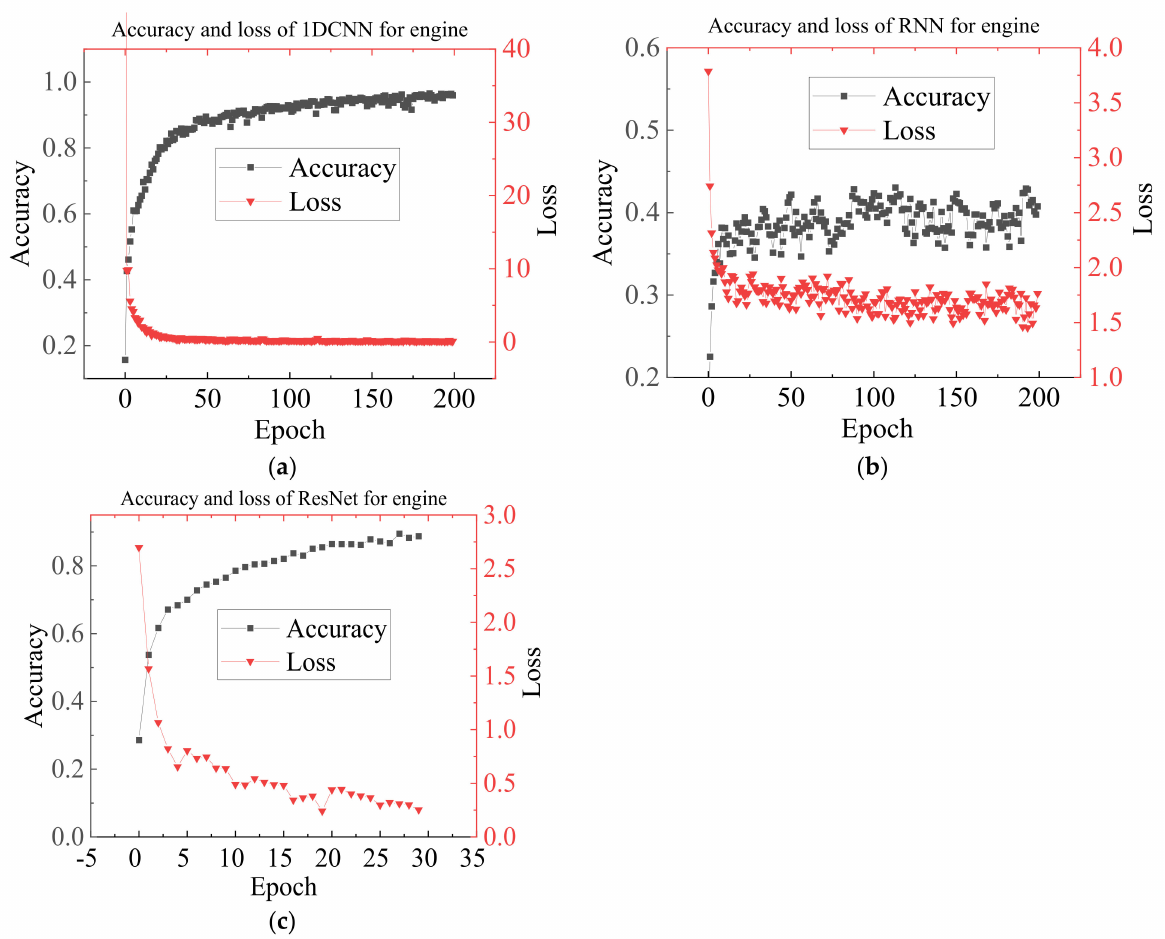
Figure 12. Accuracy and training loss of deep learning methods for 1H dataset. ( a ) Accuracy and training loss of 1DCNN. ( b ) Accuracy and training loss of LSTM-RNN. ( c ) Accuracy and training loss of